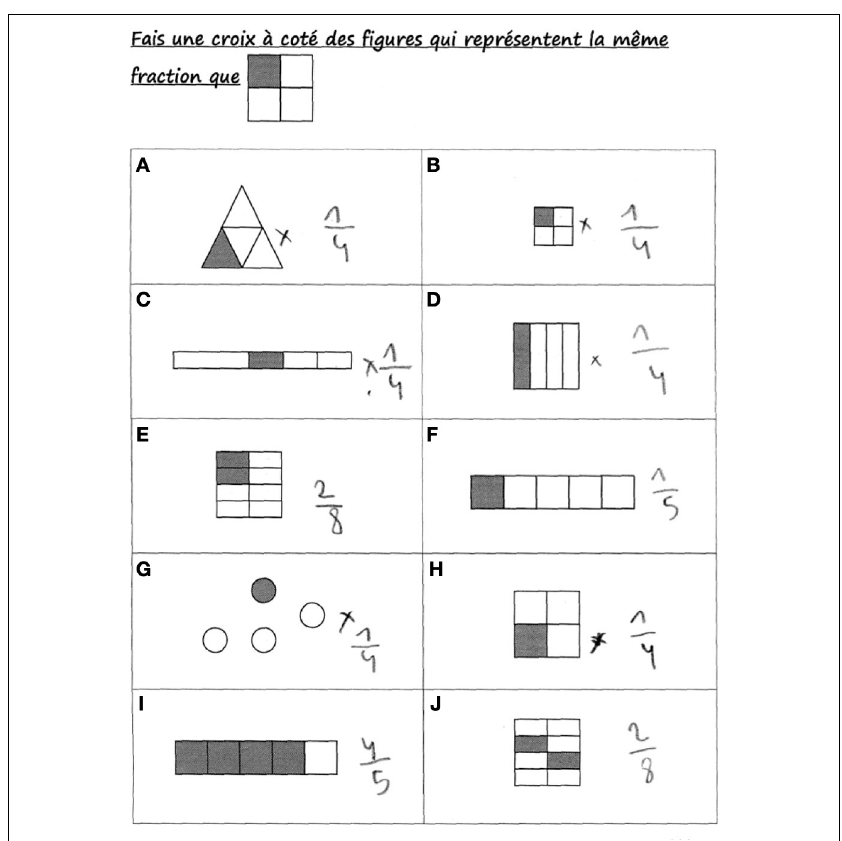
FIGURE A1 | Part-whole item: select fractions representing the same fraction as 1/4. To get full marks, children had to select panels (A,B,D,E,G,H) and (J) . In this particular example, the pupil failed to spot fractions